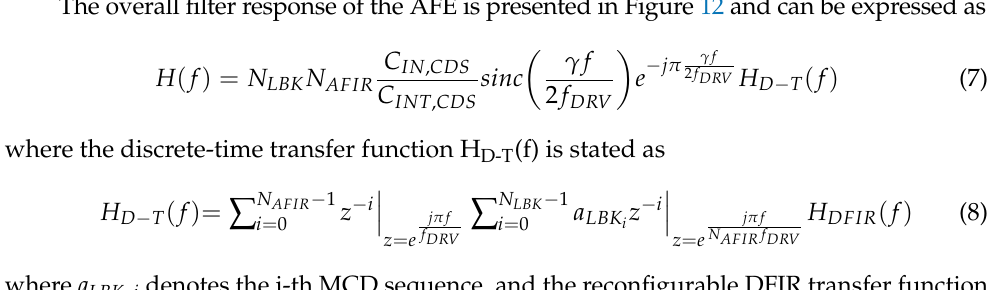
Figure 11. DFIR filtering scheme to improve SNR for C ref